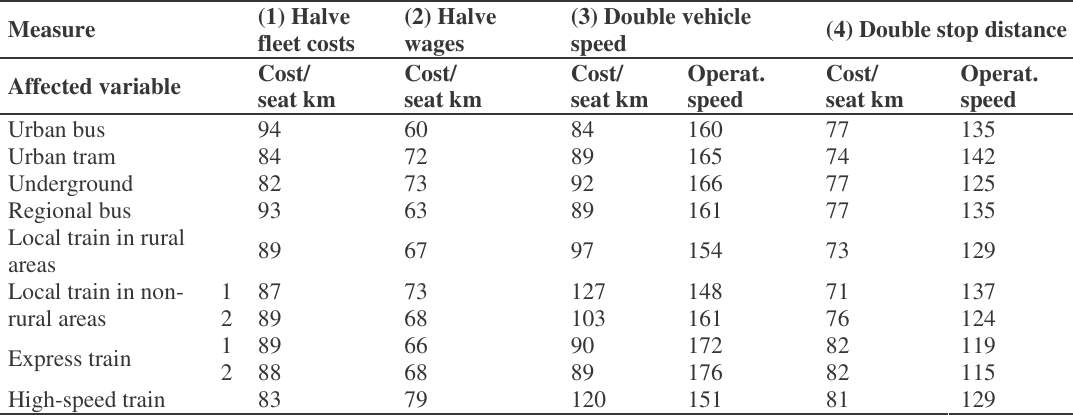
Table 5. Effects of some measures on public transport costs (no measure = 100) (1) Halve Measure fleet